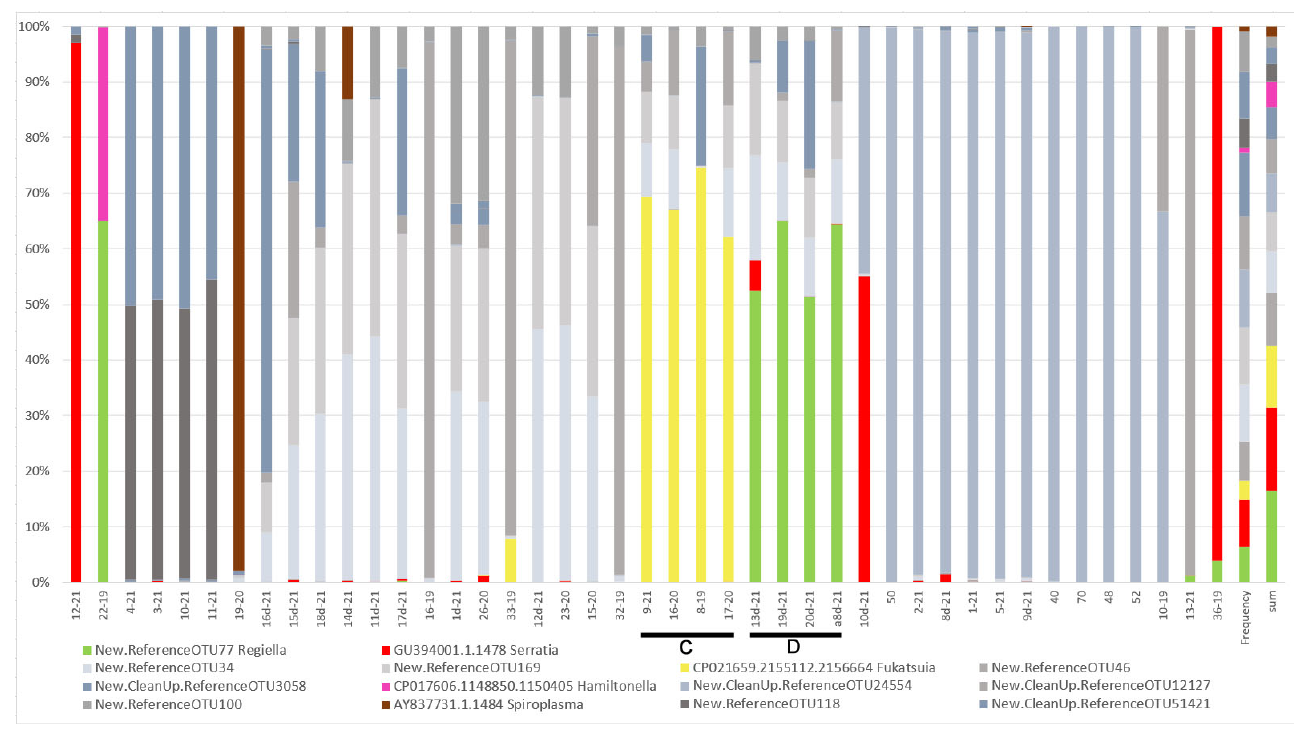
Figure 7. Shares of the next 14 most abundant OTUs with abundance >0.1%— Buchnera and secondary symbionts (affiliation with the genus presented at the name of the OTU, with the unnamed ones belonging to Buchnera ) in the studied samples. The order of samples follows the order of samples on the x-axis of the heatmap in Figure 6 (bars and letters indicate the same clades as in Figure 6).